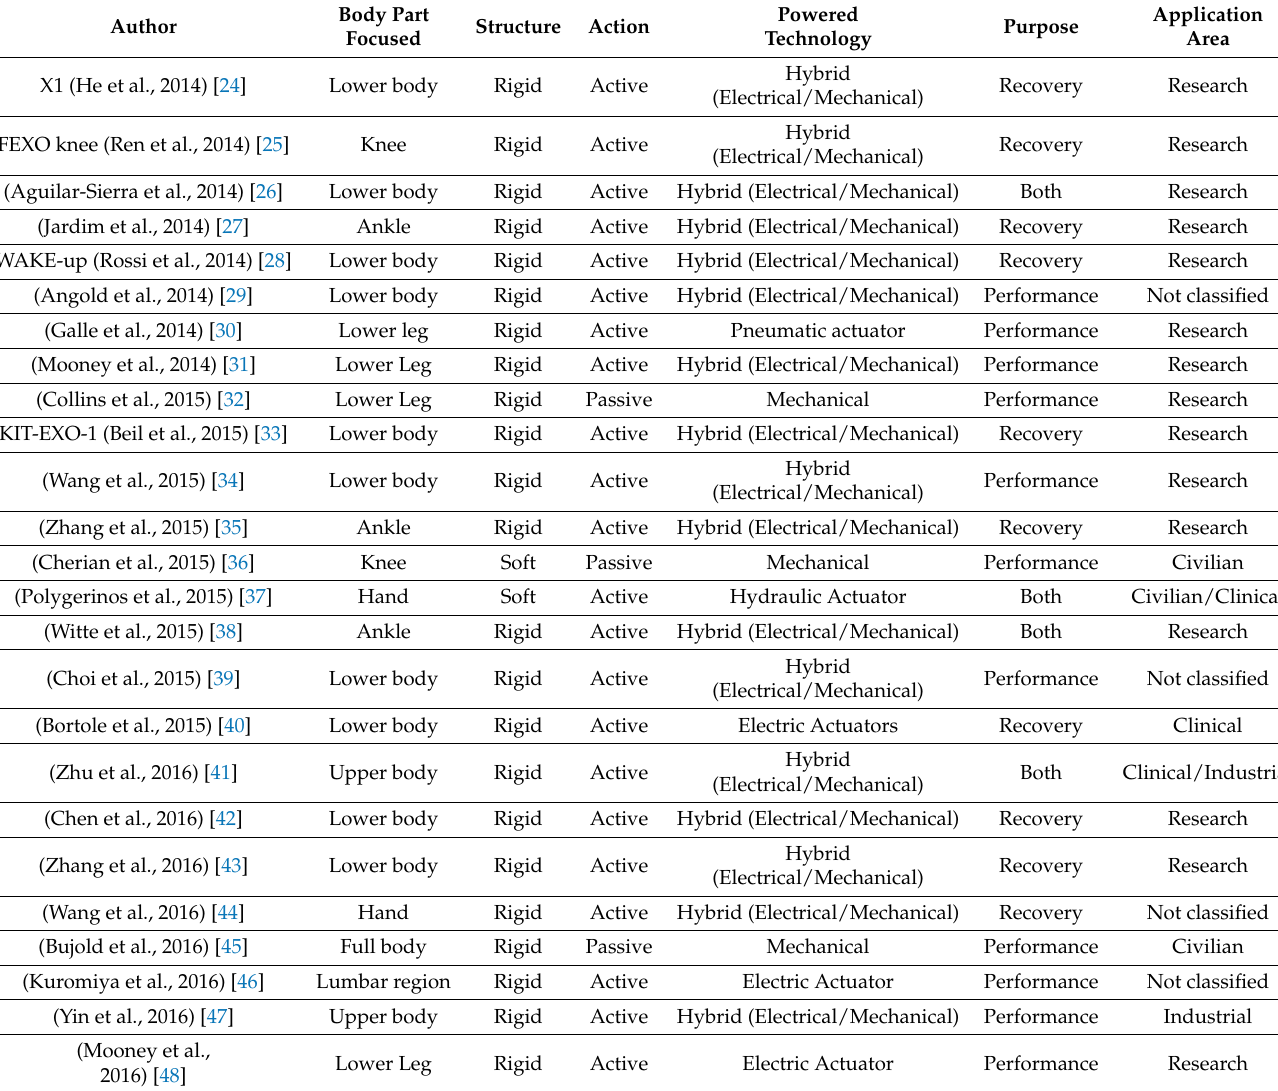
Table 1. Classification of the state-of-the-art of exoskeletons (Part